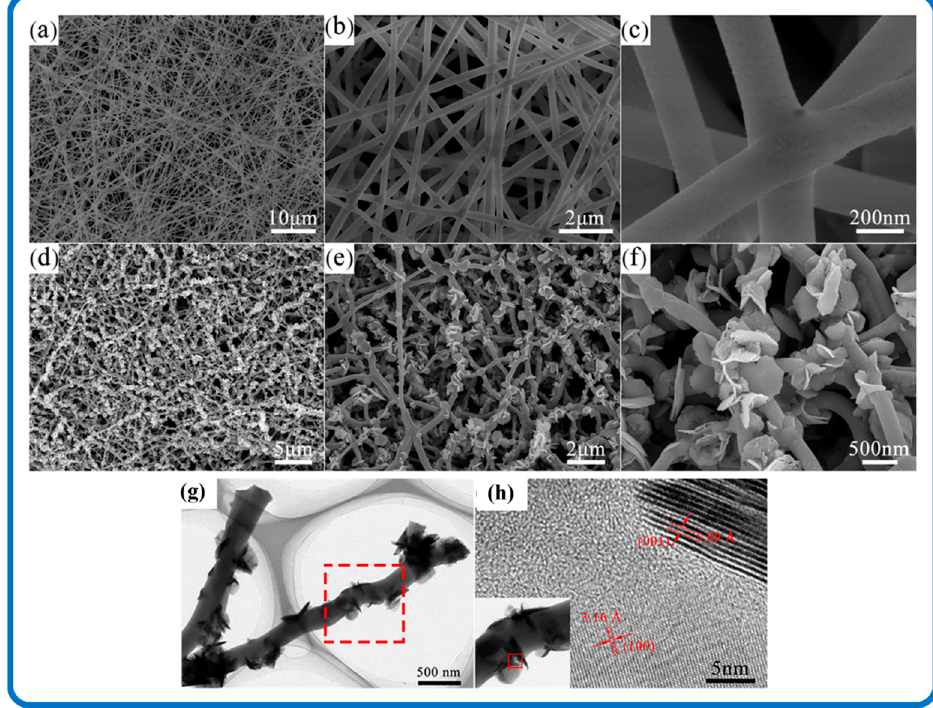
Figure 9. ( a – c ) Different-magnification FE-SEM images of carbon nanofibers and ( d – f ) SnS 2 /NSDC nanofibers. ( g ) TEM image of SnS 2 /NSDC nanofibers. ( h ) HRTEM image of SnS 2 /NSDC nanofibers marked in the red area. Reproduced with permission from [92]. Copyright 2018,